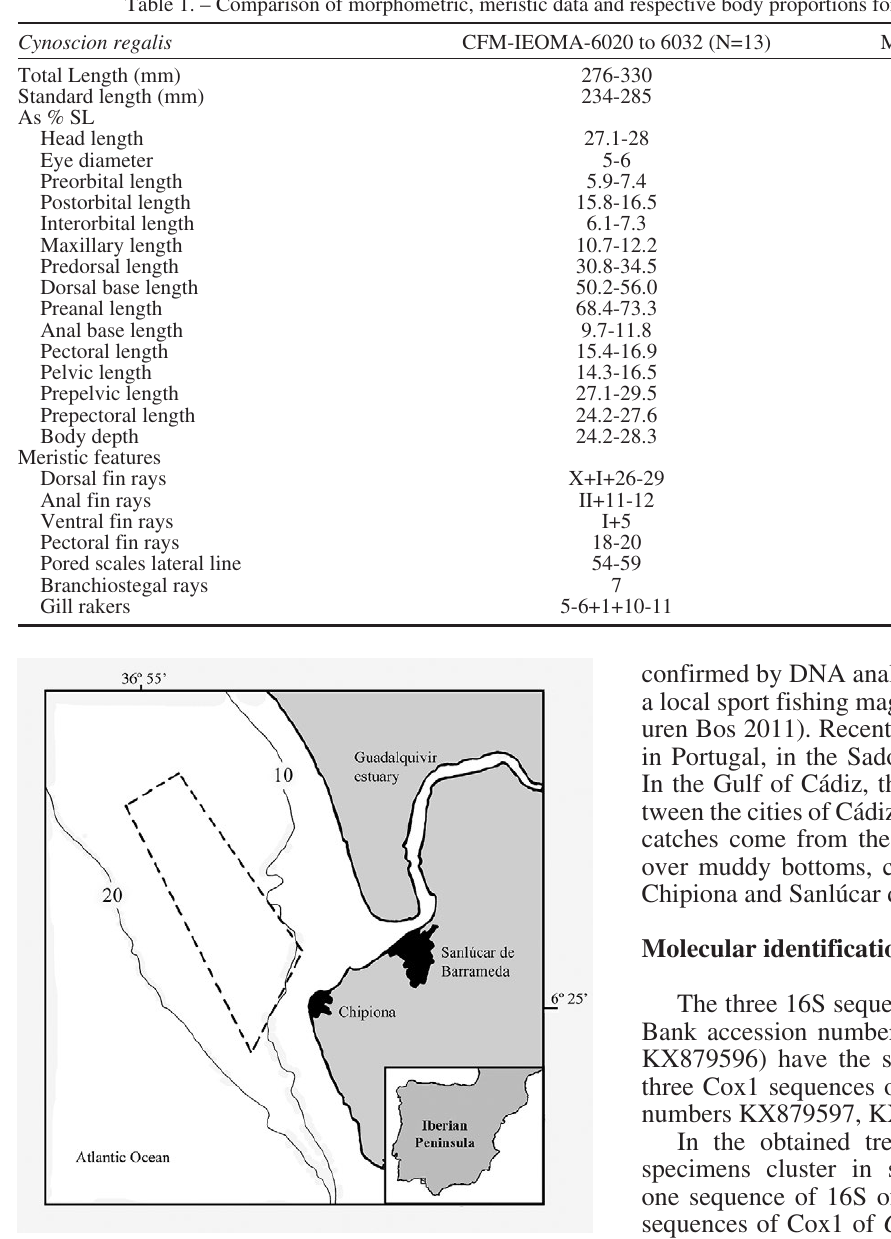
Fig. 2. – Map showing the main distribution area, framed by dashed line, of C. regalis in the Gulf of Cádiz based on fisheries